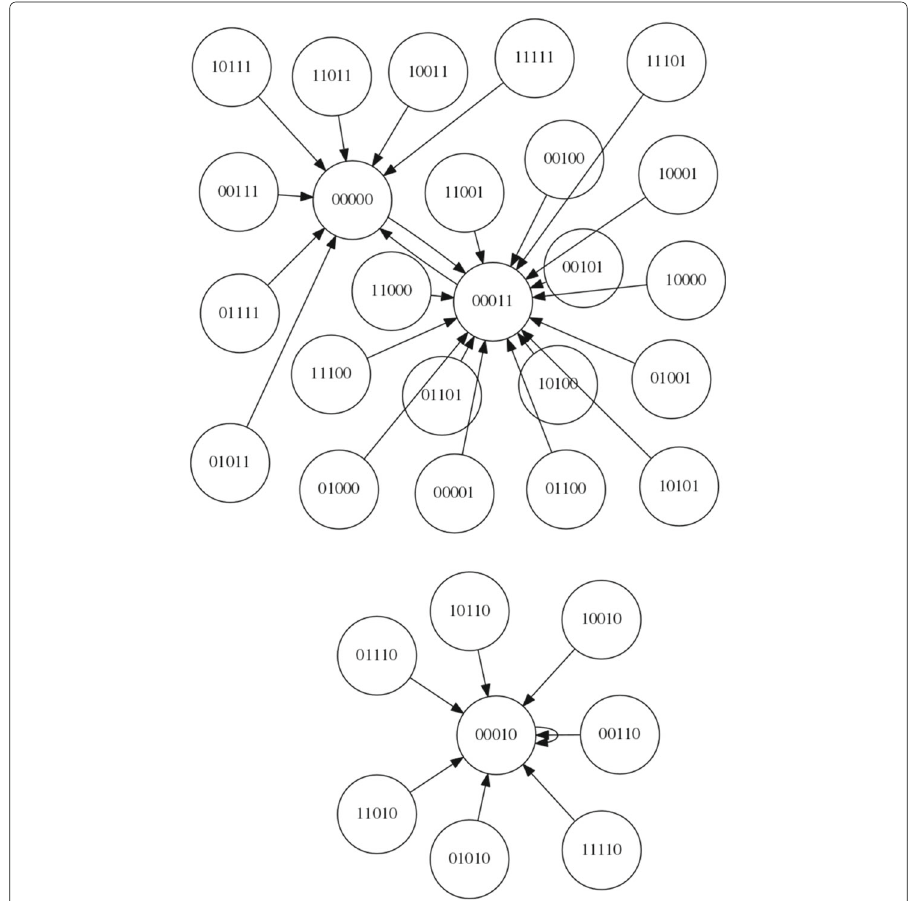
Fig. 7 NK Boolean network, instantiation 1 ( N = 5, K =